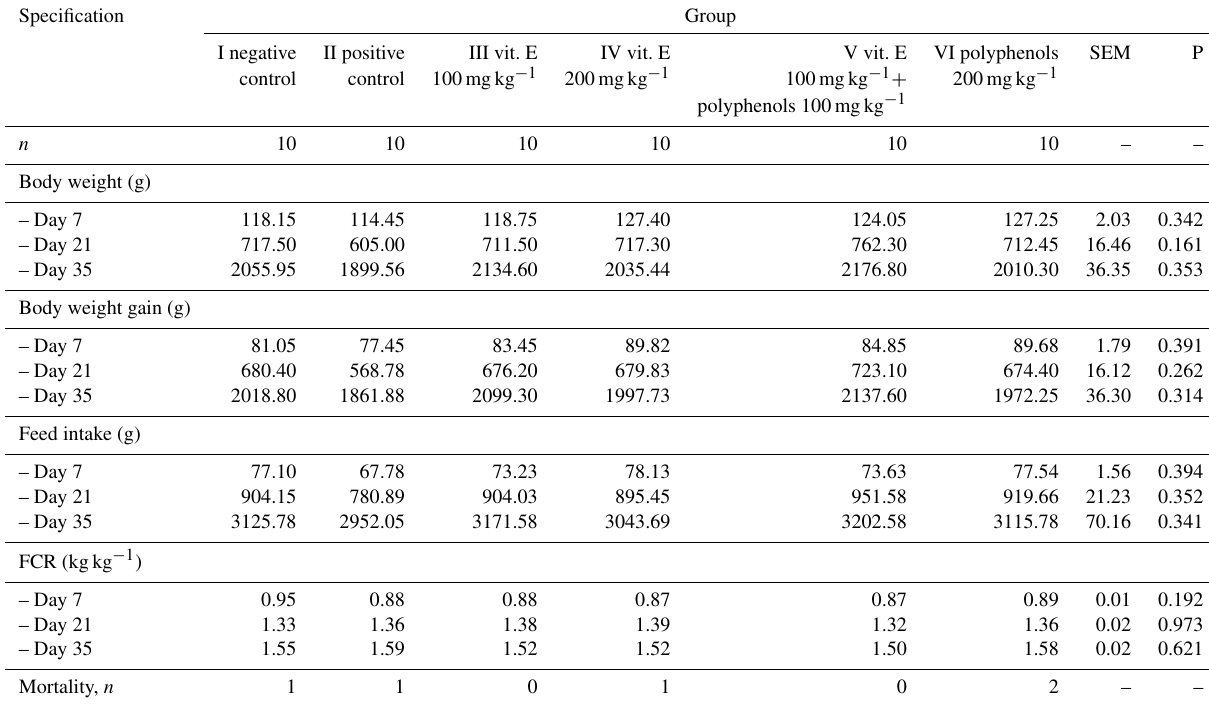
Table 3. Growth performance of broiler chickens fed low-quality oil. Specification